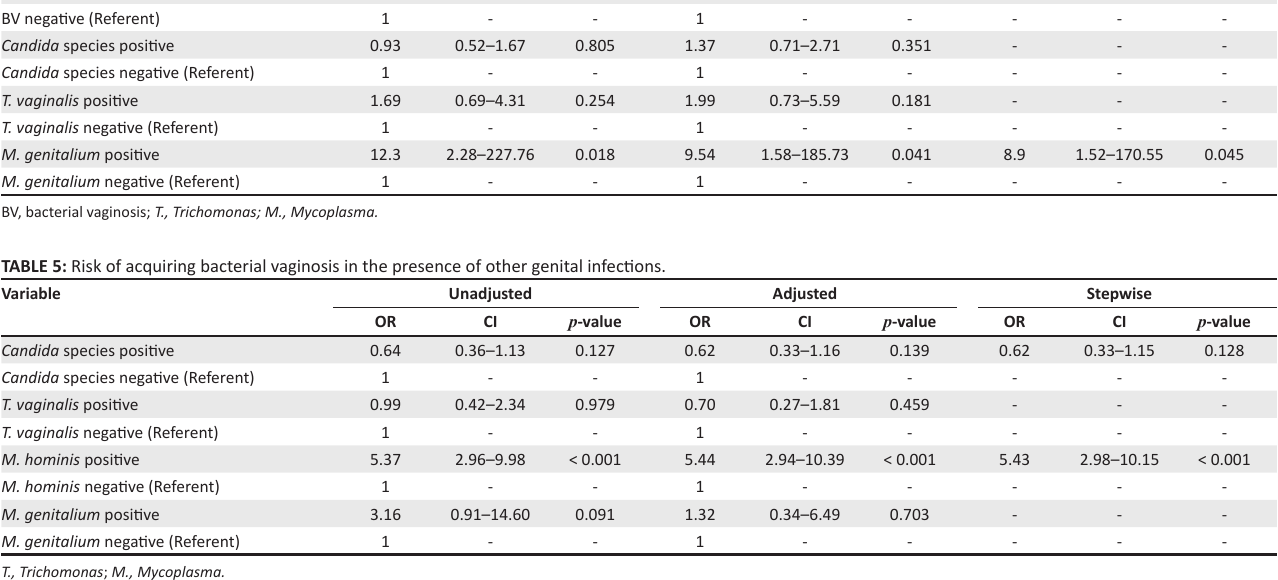
Candida species positive